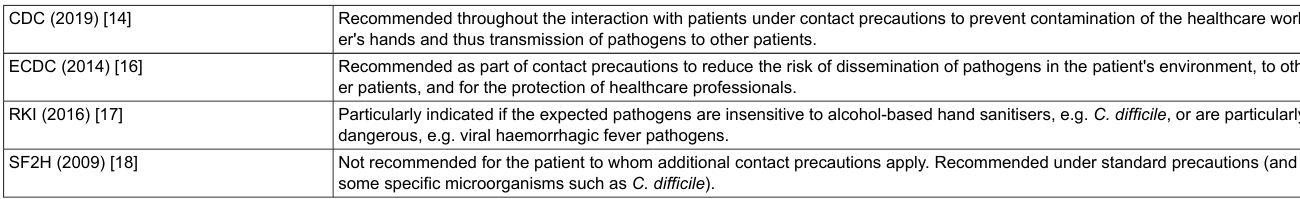
Table 1: Use of gloves and contact precautions: comparison of